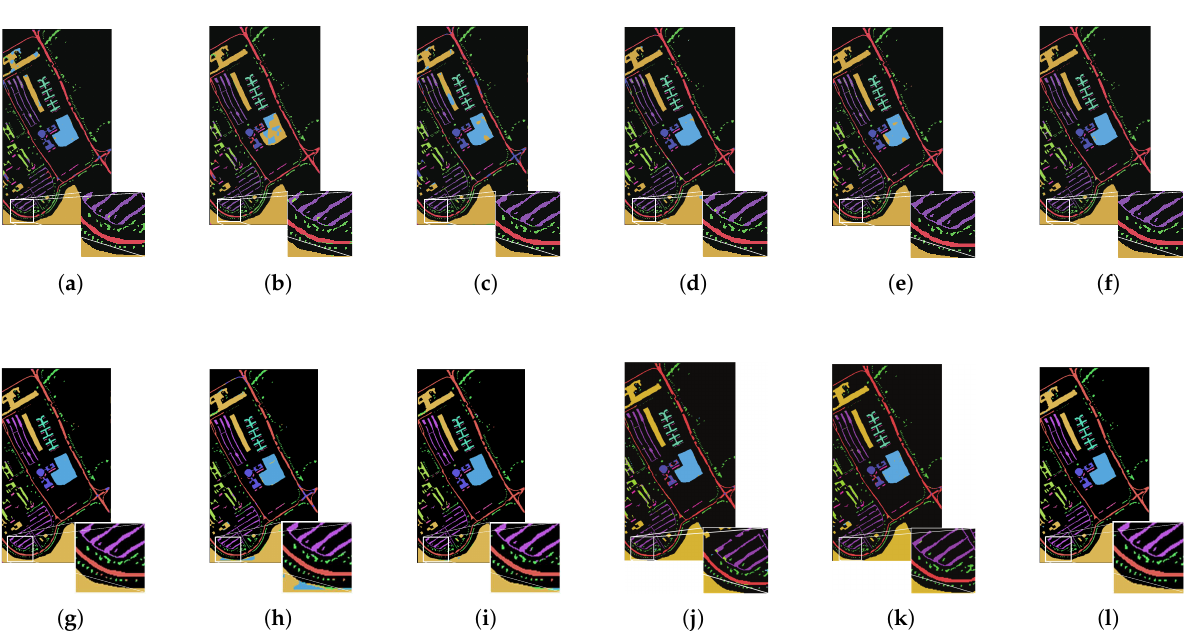
Figure 8. Classification maps for PU data set. ( a ) SVM. ( b ) RF. ( c ) MLR. ( d ) ResNet. ( e ) PyResNet.